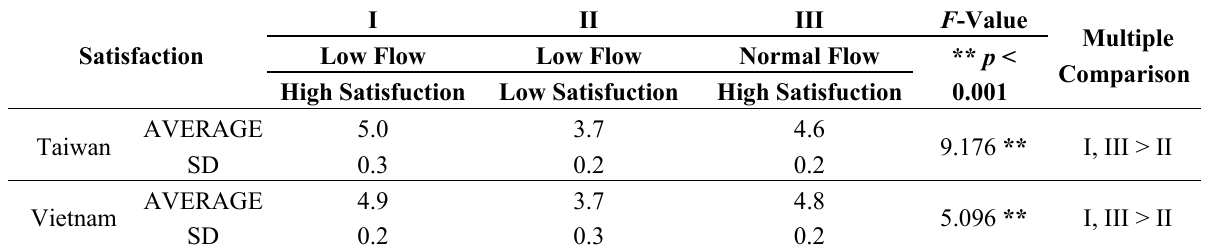
Table 3. Result of ANOVA and multiple comparisons (satisfaction).